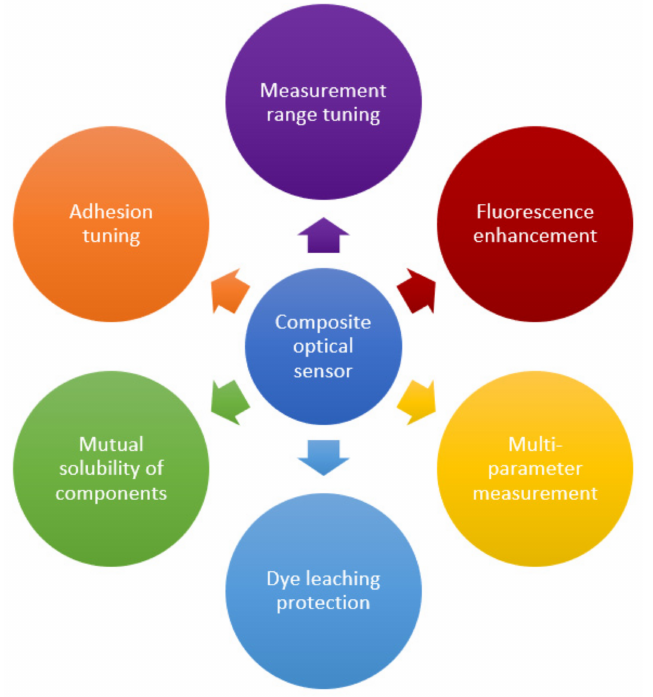
Figure 6. The main qualitative improvements in optical sensors achieved through the creation of composite